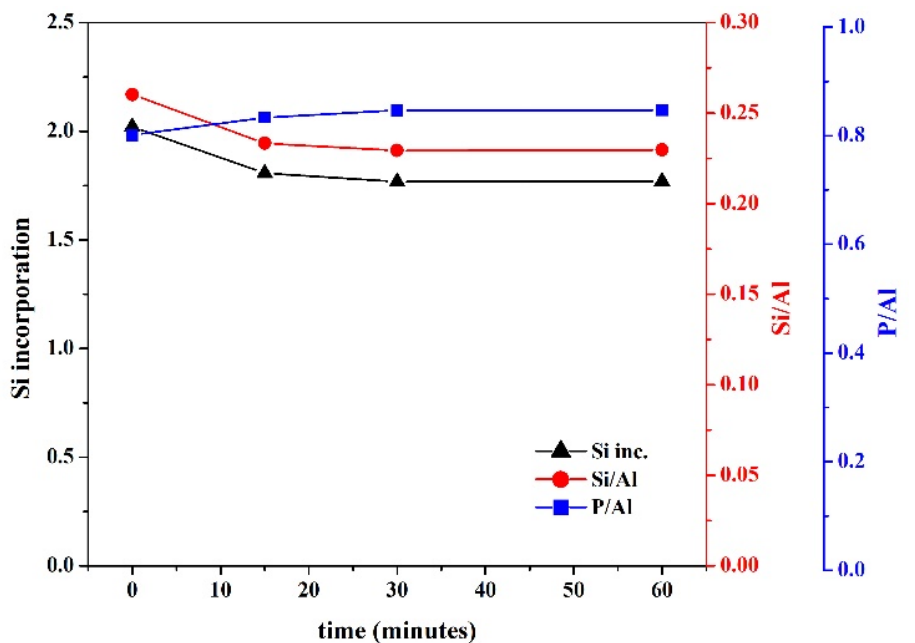
Figure 6. FTIR of the gels prepared with different phosphoric acid addition time (S13-S16): ( a ) 2000 − 4000 cm - 1 , and ( b ) 400 − 2000 cm -1.